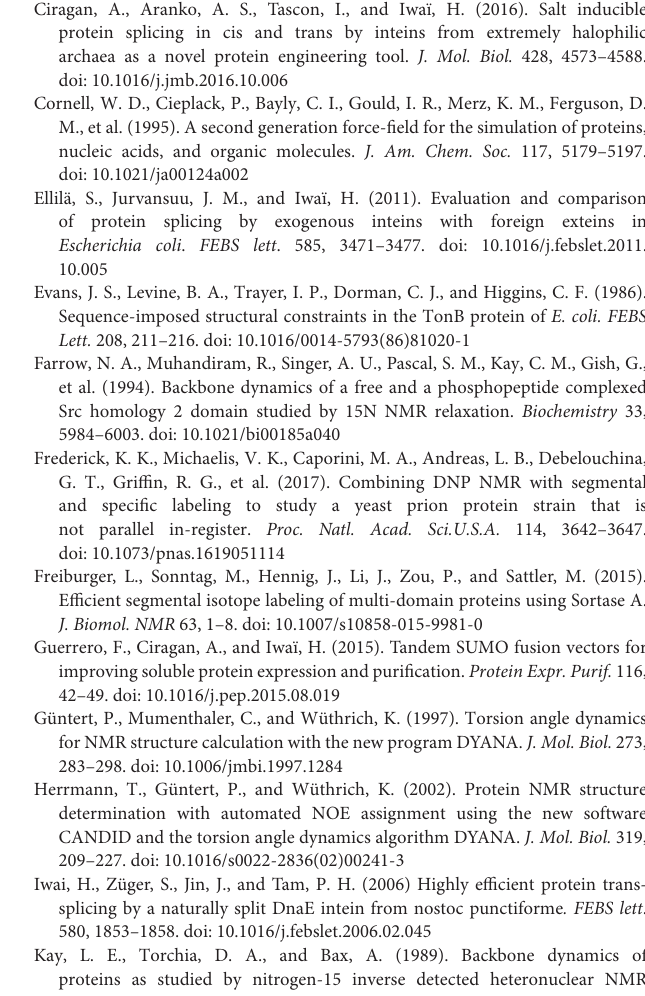
Figure S1 | Sequence alignment of TonB protein from four gram-negative bacteria (HP, Helicobacter pylori ; EC, Escherichia coli ; ST, Salmonella typhimurium ; PA, Pseudomonas aeruginosa ). Black color indicates identical residues, and gray color indicates residues with similar chemical characteristics. The asterisk ( ∗ ) indicates the position of the conserved histidine (except for HP ) in the transmembrane domain. The domain arrangement of Hp TonB is shown above the amino-acid sequence. Figure S2 | Comparison of the two [ 1 H, 15 N]-HSQC spectra of (A) Hp TonB 92 and (B) Hp TonB 107 Sequence-specific assignments are marked for each peak with one-letter codes for amino-acid